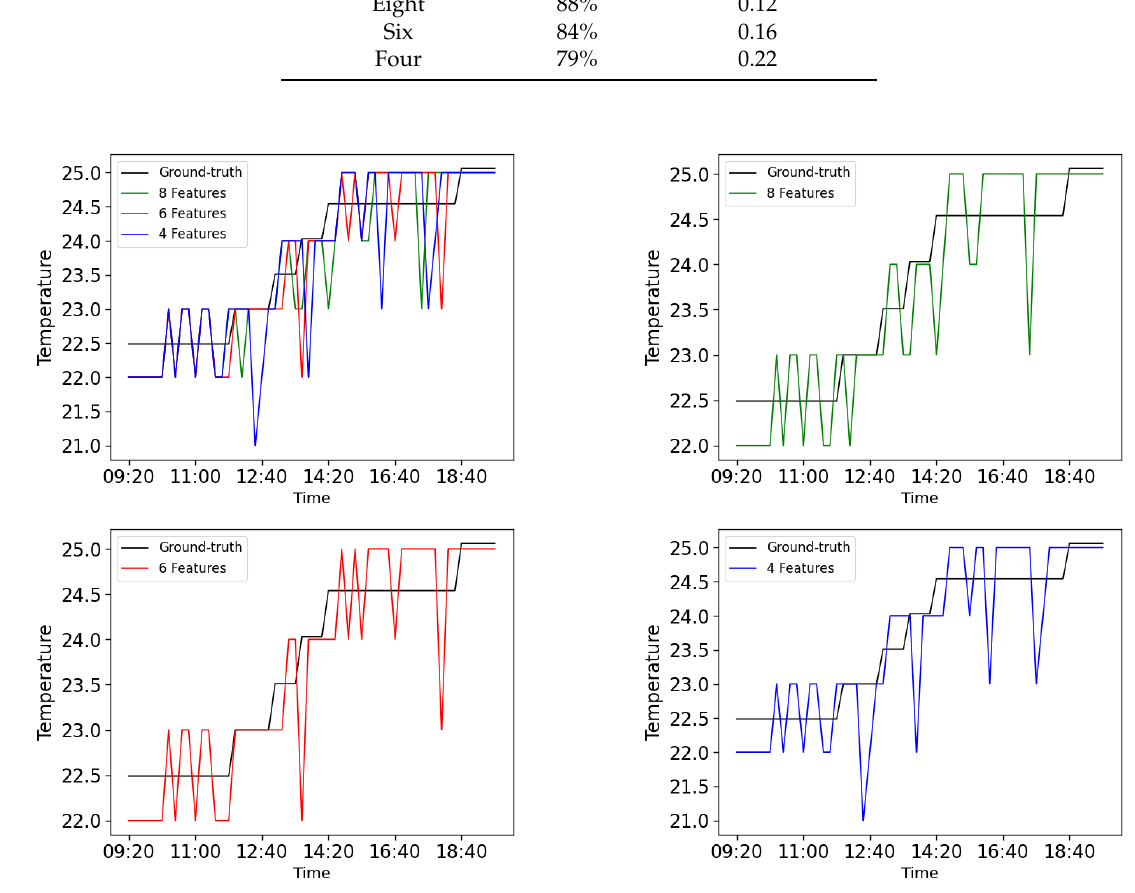
Figure 7. The accuracy of forecasting temperature in dynamic